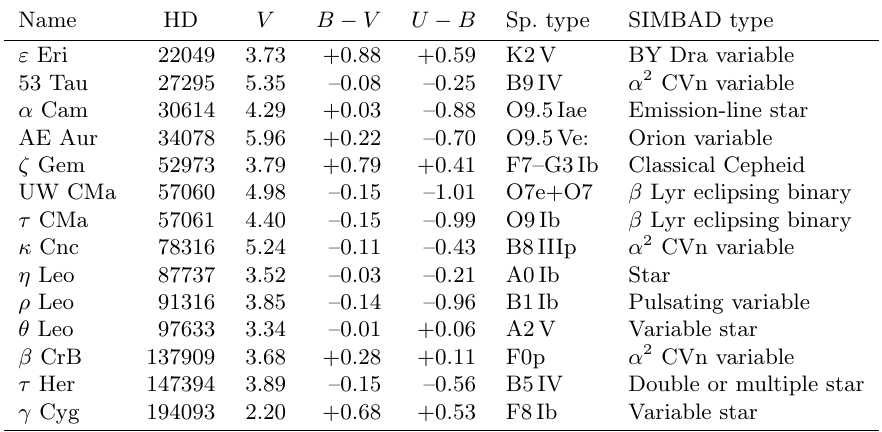
Table 1. Stars common to both the Astron and NGSL